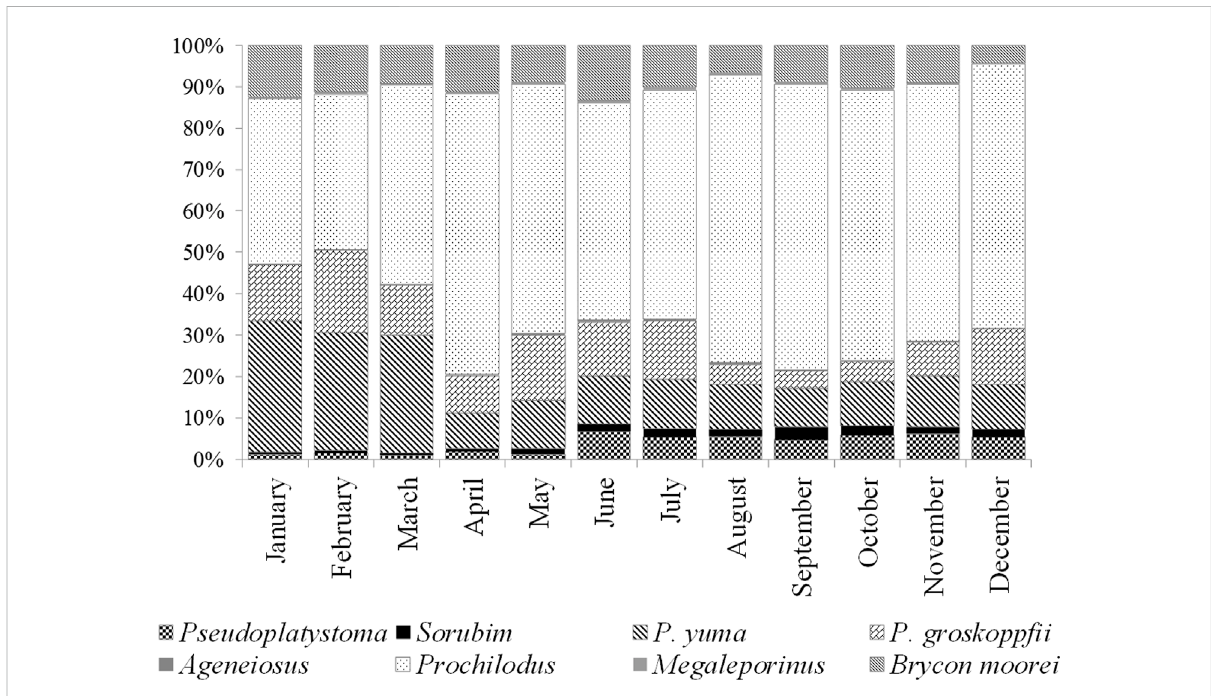
FIGURE 10 Percent of each potamodromous fi sh species to the monthly landings in the Magdalena River basin from 1993 to 1999. Black line: annual average tons. Data obtained from INPA (1998), INPA